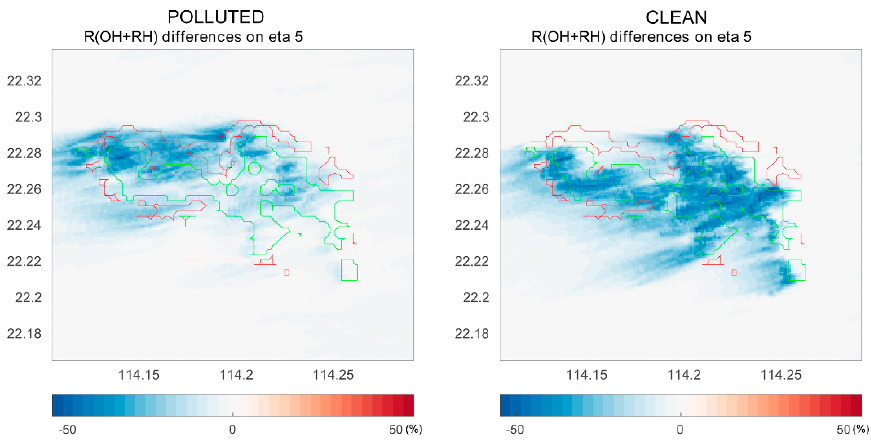
Figure 5. The differences in the reaction rates of OH with hydrocarbons (RH-A and RH-B) at model level 5 (approximately 200 m above ground) with and without segregation. Left panel: polluted conditions; right panel: clean conditions. Table 2. Number of moles of RH-A/RH-B destroyed by OH integrated during a time period of 1 h over the lowest 20 model levels (below ~800 m) in the urban area, the forested area, and the entire domain, respectively. The results are provided for the POLLUTED and CLEAN cases. “seg” repre- sents segregation.